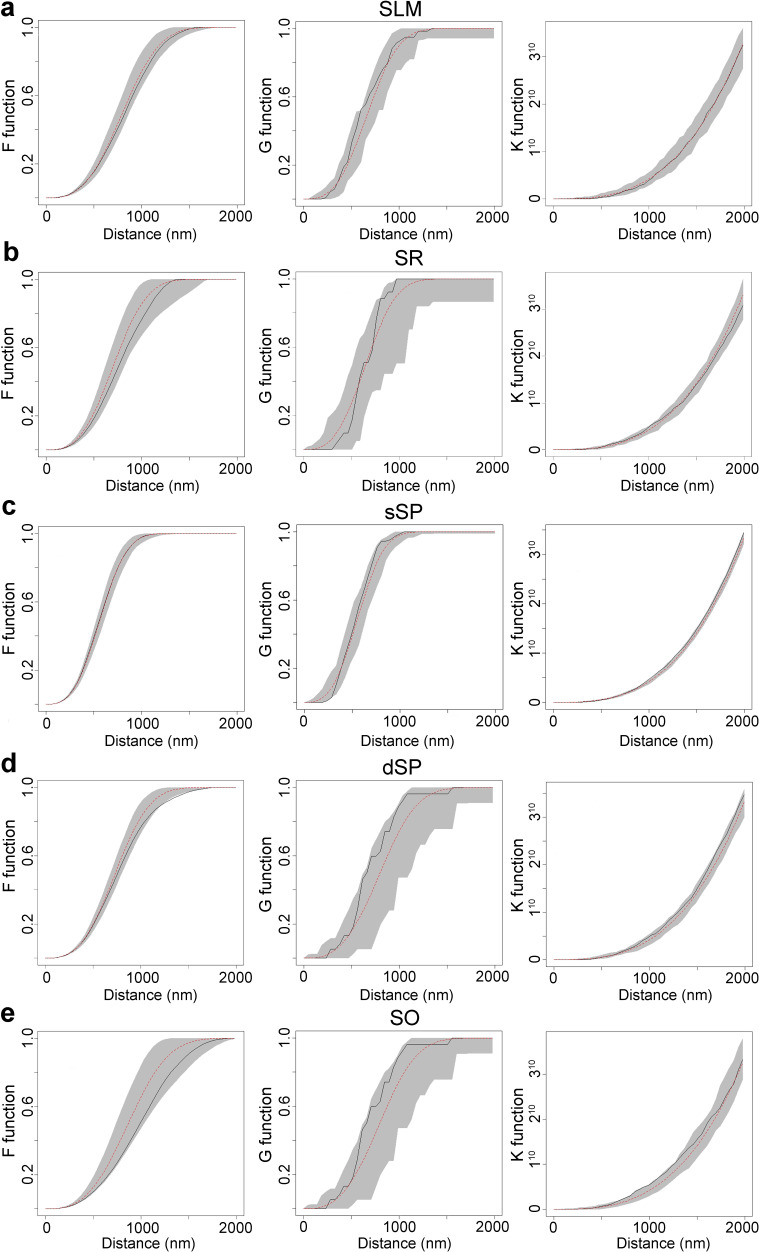
Analysis of the synaptic spatial distribution in the neuropil.(a−e) F, G and K functions obtained in each layer: SLM (a), SR (b), sSP (c), dSP (d) and SO (e). Red dashed traces correspond to a theoretical homogeneous Poisson process for each function (F, G, K). The black continuous traces correspond to the experimentally observed function. The shaded areas represent the envelopes of values calculated from a set of 99 simulations. All plots show a distribution which fits a Poisson function in all strata which is representative of a random spatial distribution. SO: stratum oriens; dSP: deep stratum pyramidale; sSP: superficial stratum pyramidale; SR: stratum radiatum; SLM: stratum lacunosum-moleculare.